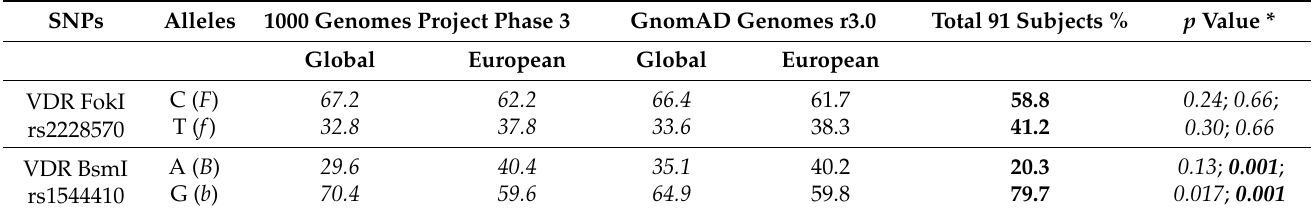
Table 2. Comparison between allele frequencies obtained from the genotyping of our study and the allele frequency data available from the 1000 Genomes and GnomAD